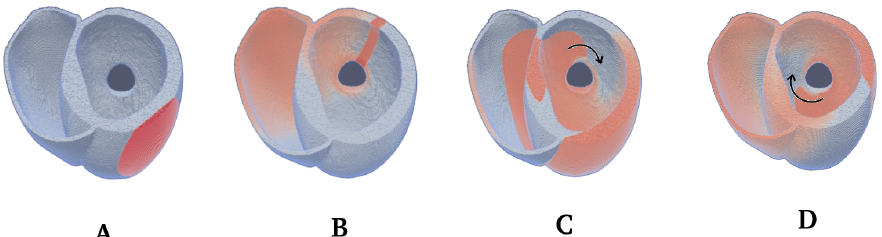
Figure 3. Initiation of the rotational activity using S1–S2 protocol: S1 stimulus ( A ), S2 stimulus ( B ), and wave rotation around a scar ( C , D ). Arrows show direction of the wave rotation. There are 397273 points in a geometry on the